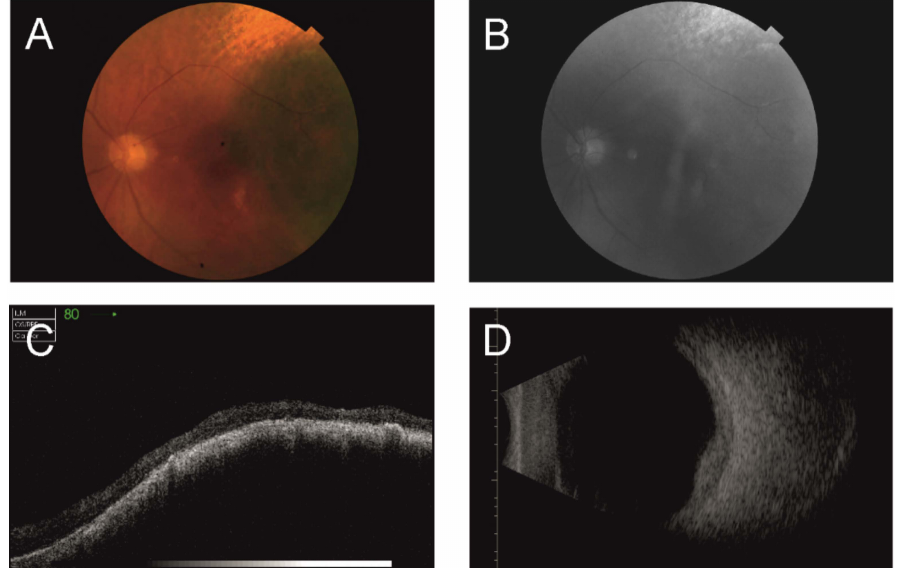
Figure 2. Choroidal melanoma: fundus photography ( A ), red-free image ( B ), OCT scan ( C ), and US ( D ).